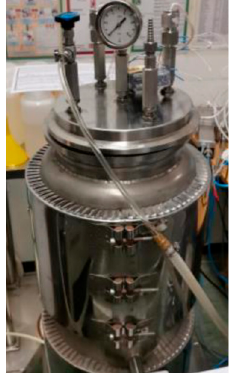
Figure 4. ( Left ): Autoclave HR-28L of the company Berghof; ( Middle ): RH, Temperature; ( Right ): Pressure and CO 2 concentration during accelerated carbonation at planned conditions of 2 barg (=3 bar), 20 °C and 3 vol.% CO 2.